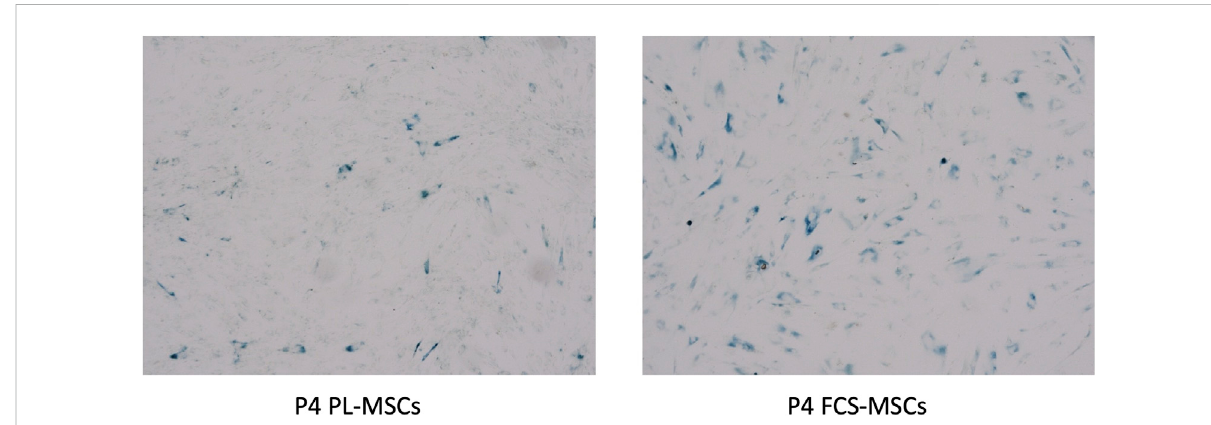
FIGURE 5 β -galactosidasestainingofcultured MSCs.Cellsfromarepresentativedonorwerecultured inbothmediaandstainedafter4passages. More β - galactosidase positive (blue colorored) cells were found in MSC cultures with FCS based expansion medium versus PL-based medium (4 × magni fi cation) (P4 = passage 4).